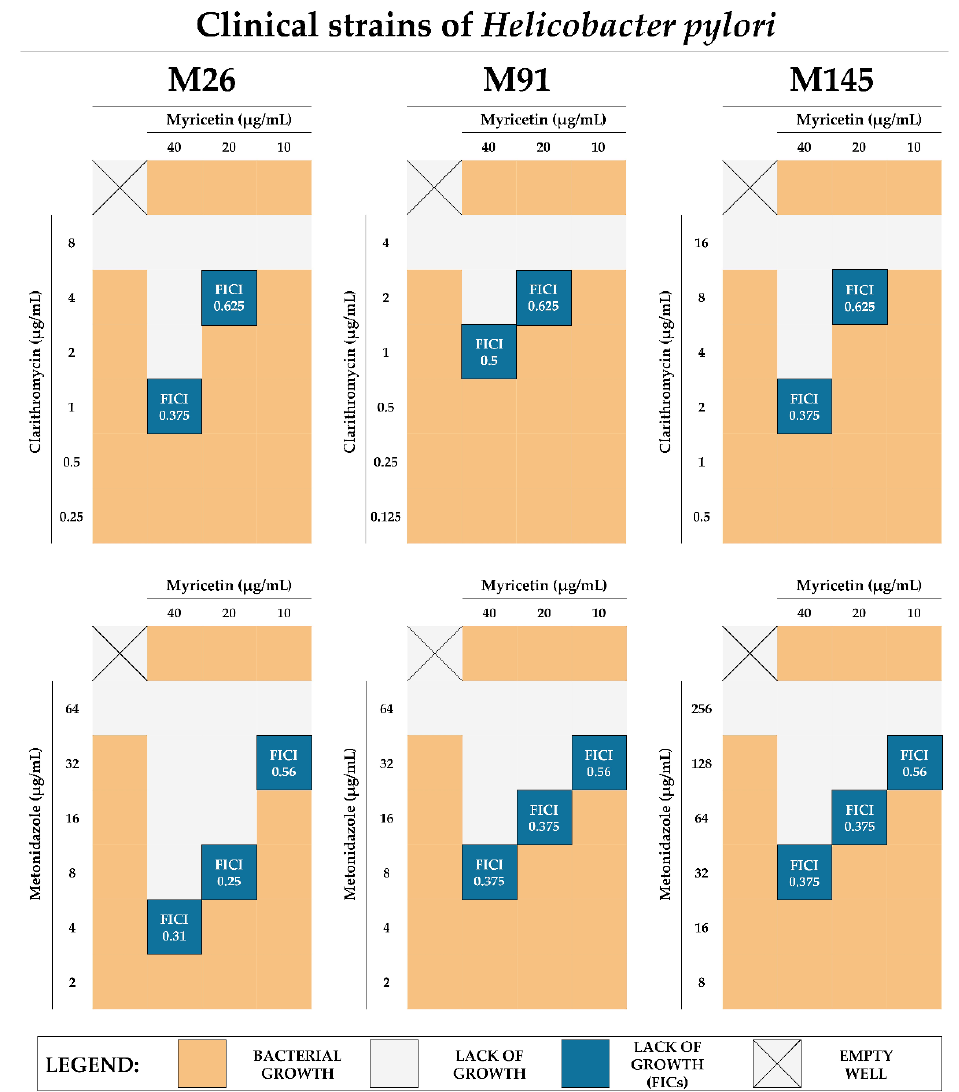
Figure 6. Graphical representation of the results of checkerboard assays testing synergistic interac- tions between myricetin and two selected antibiotics (clarithromycin and metronidazole) against clinical, double-resistant H. pylori strains (clarithromycin- and metronidazole-resistant). The MIC of myricetin for all strains is equal to 160 µg/mL. The MICs for clarithromycin count for 8, 4, and 16 µg/mL for H. pylori M26, M91, and M145, respectively. The MICs for metronidazole are equal to 64, 64, and 256 µg/mL for H. pylori M26, M91, and M145, respectively. The blue field marks the wells of